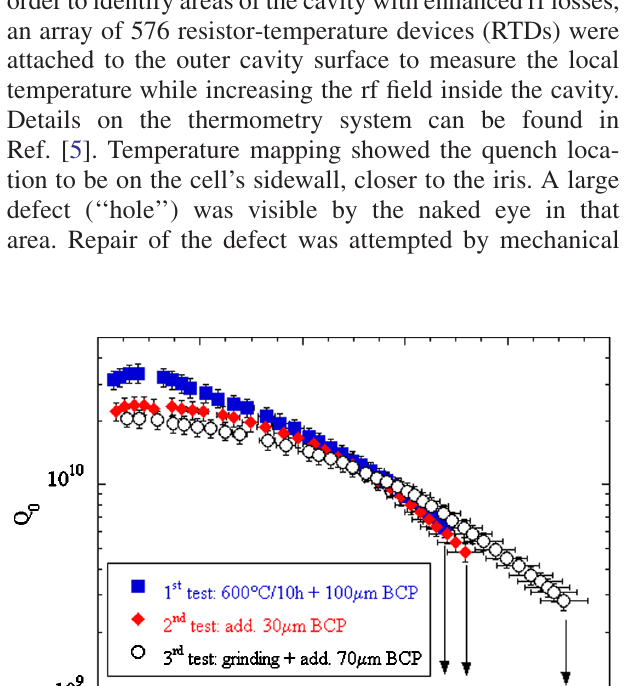
FIG. 2. ‘‘Unfolded’’ temperature map at 1.7 K at the highest field achieved in rf test No. 3, just before quench. Sensors No. 1 and No. 16 are located at the top and bottom iris of the vertically mounted cavity, respectively, while the equator weld is between sensors No. 8 and No. 9. Twelve samples, nine from hotspots and three from coldspots, with locations indicated by a red box, were cut from the cavity by milling for surface